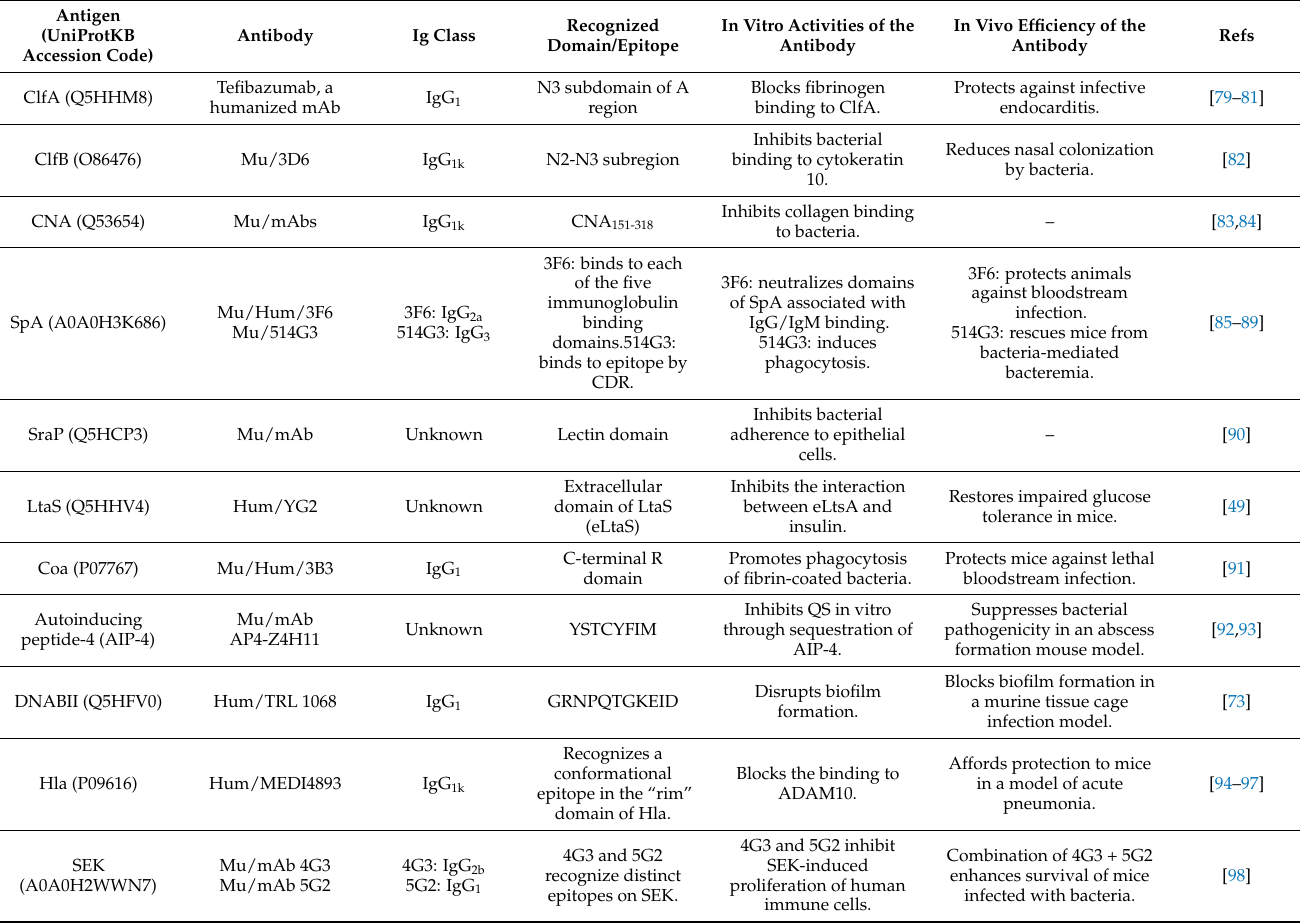
Table 1. Targets for antibody-based therapies against S. aureus